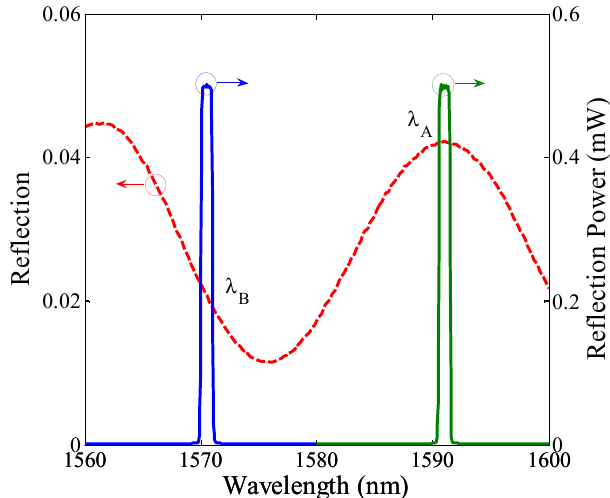
Figure 8. Using 2 laser diodes (LDs) to monitor the reflective power spectrum at 20 °C.